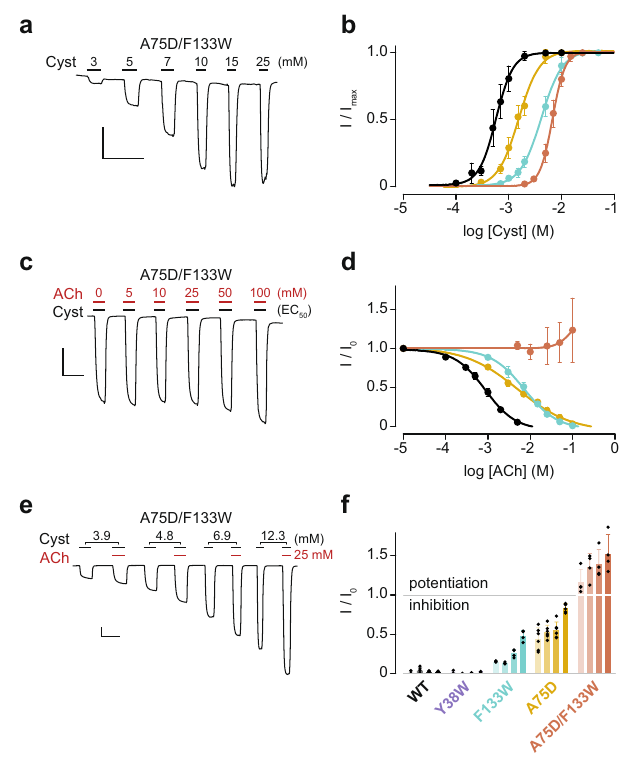
Fig. 3 Cysteamine and ACh sensitivity of the A75D/F133W double mutant ELIC. a , c Representative whole-cell traces and b , d corresponding dose response curves are shown for a , b cysteamine (Cyst) activation and c , d ACh inhibition of cysteamine-activated currents. In both cases, the duration of cysteamine and ACh applications (black and red bars, respectively) and ligand concentrations (mM) are indicated above the traces. In ( c ) the cysteamine concentration was fi xed at its EC 50 for the A75D/F133W double mutant (6.9 mM). The dose response curves for wild- type ELIC (black), A75D (orange), F133W (green) and A75D/F133W (burgundy) are shown. Error bars in ( b , d ) represent one standard deviation from the mean, obtained from a minimum of 6 independent oocyte replicates. e The cysteamine concentration corresponding to EC 10 (3.9 mM), EC 20 (4.8 mM), EC 50 (6.9 mM), and EC 90 (12.3 mM) is indicated above each peak, with ACh fi xed at 25 mM (red bars). f The normalized response at each cysteamine concentration for wild-type (WT) and various mutant ELICs are shown as a bar graph with each data point overlaid as a dot. Each mutant and the wild type were characterized with four cysteamine concentrations, corresponding to EC 10 , EC 20 , EC 50 , and EC 90 (left to right) are depicted as different saturation levels (light to dark; EC 10 to EC 90 ). Error bars represent one standard deviation from the mean, obtained from a minimum of 4 independent oocyte replicates. The x - and y - axis of the scale bar in panels ( a , c , e ) corresponds to 1 min and 0.5 µ A,